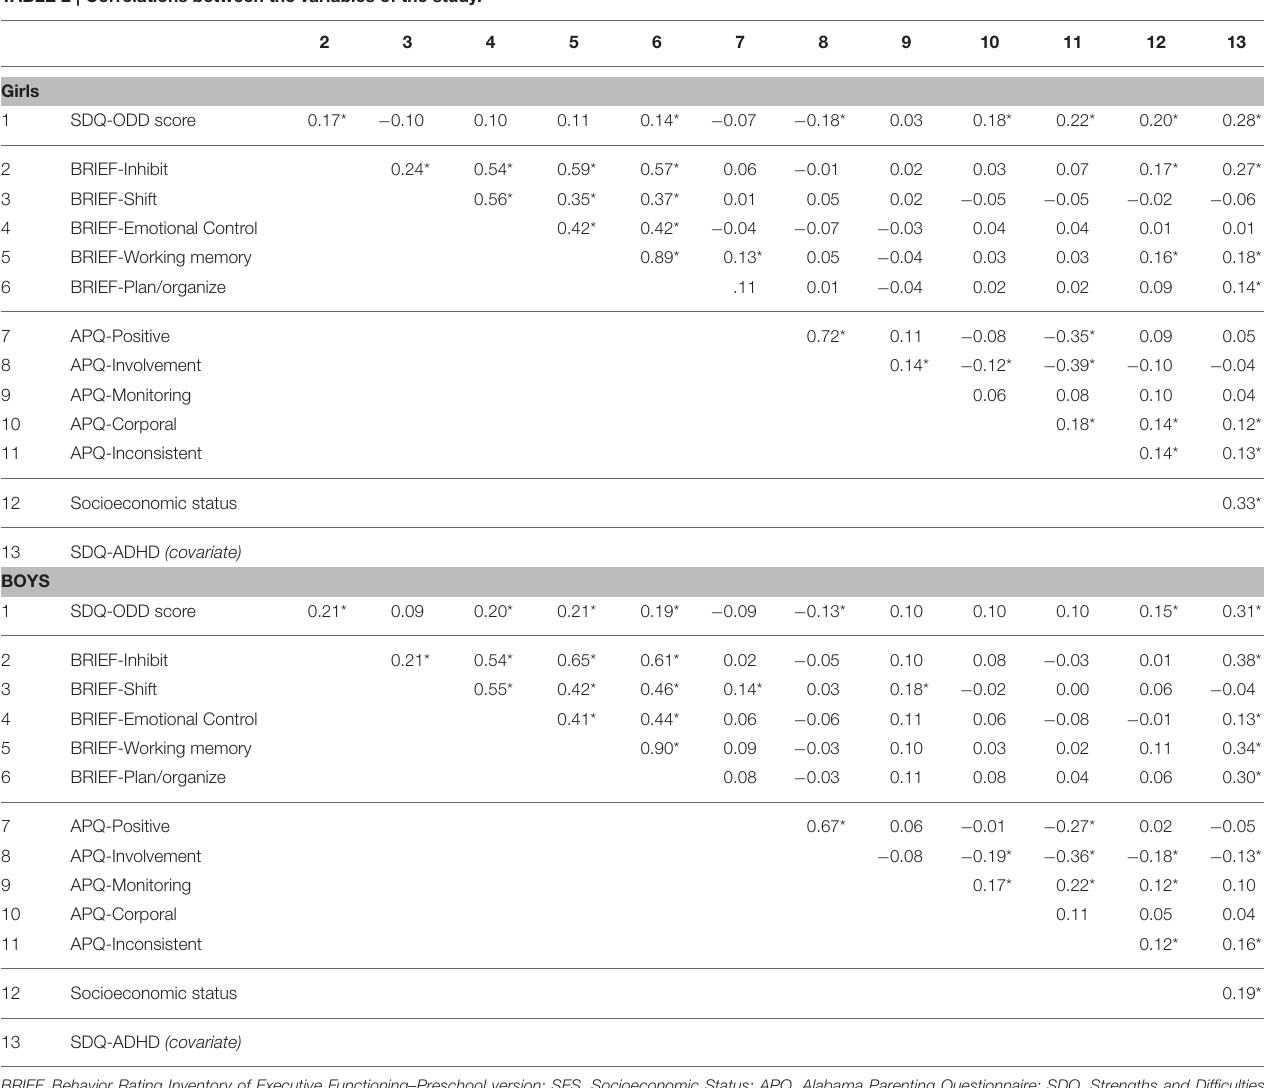
TABLE 2 | Correlations between the variables of the